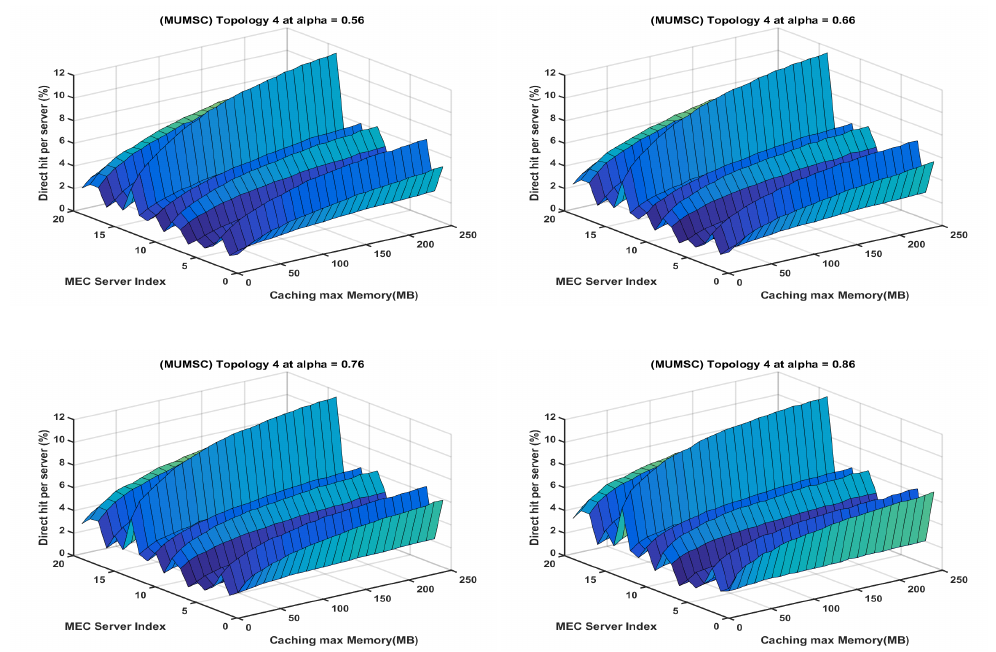
Figure 15. Heatmap represents direct hit rate vs. caching max Memory per each server for the MUMSC algorithm at different α